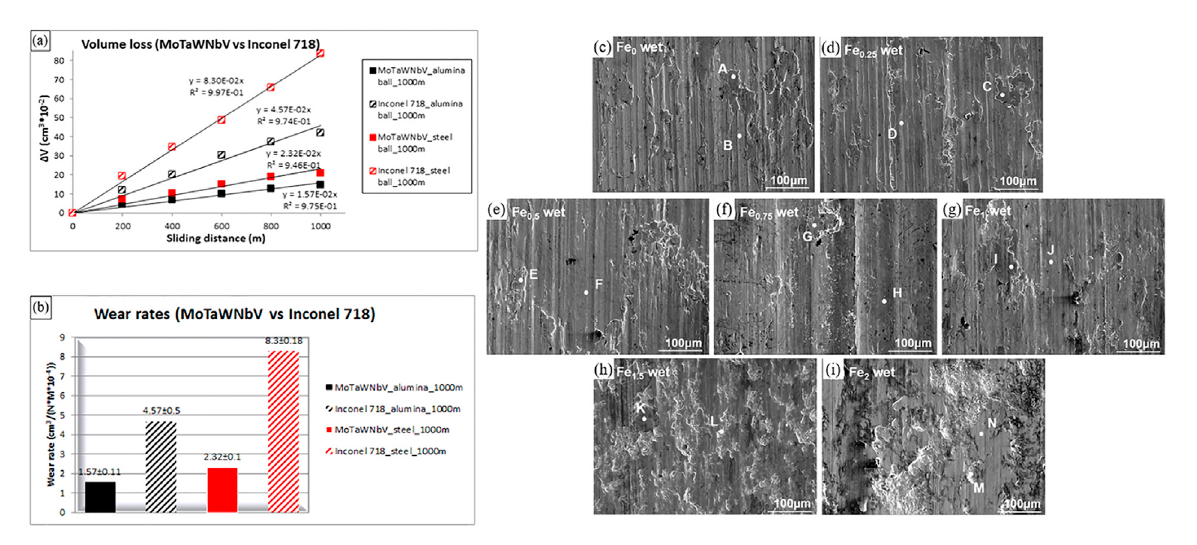
FIGURE 18 (A, B) Comparison of frictional properties of MoTaWNbV high entropy alloy and Inconel 718 conventional high-temperature alloy, using aluminum oxide and steel balls as counter body materials (Poulia et al., 2016). C – I SEM images of worn-scar surfaces of the Ti-Zr-Hf-Nb-Fe x HEAs under PBS wet wear conditions (Wang et al.,